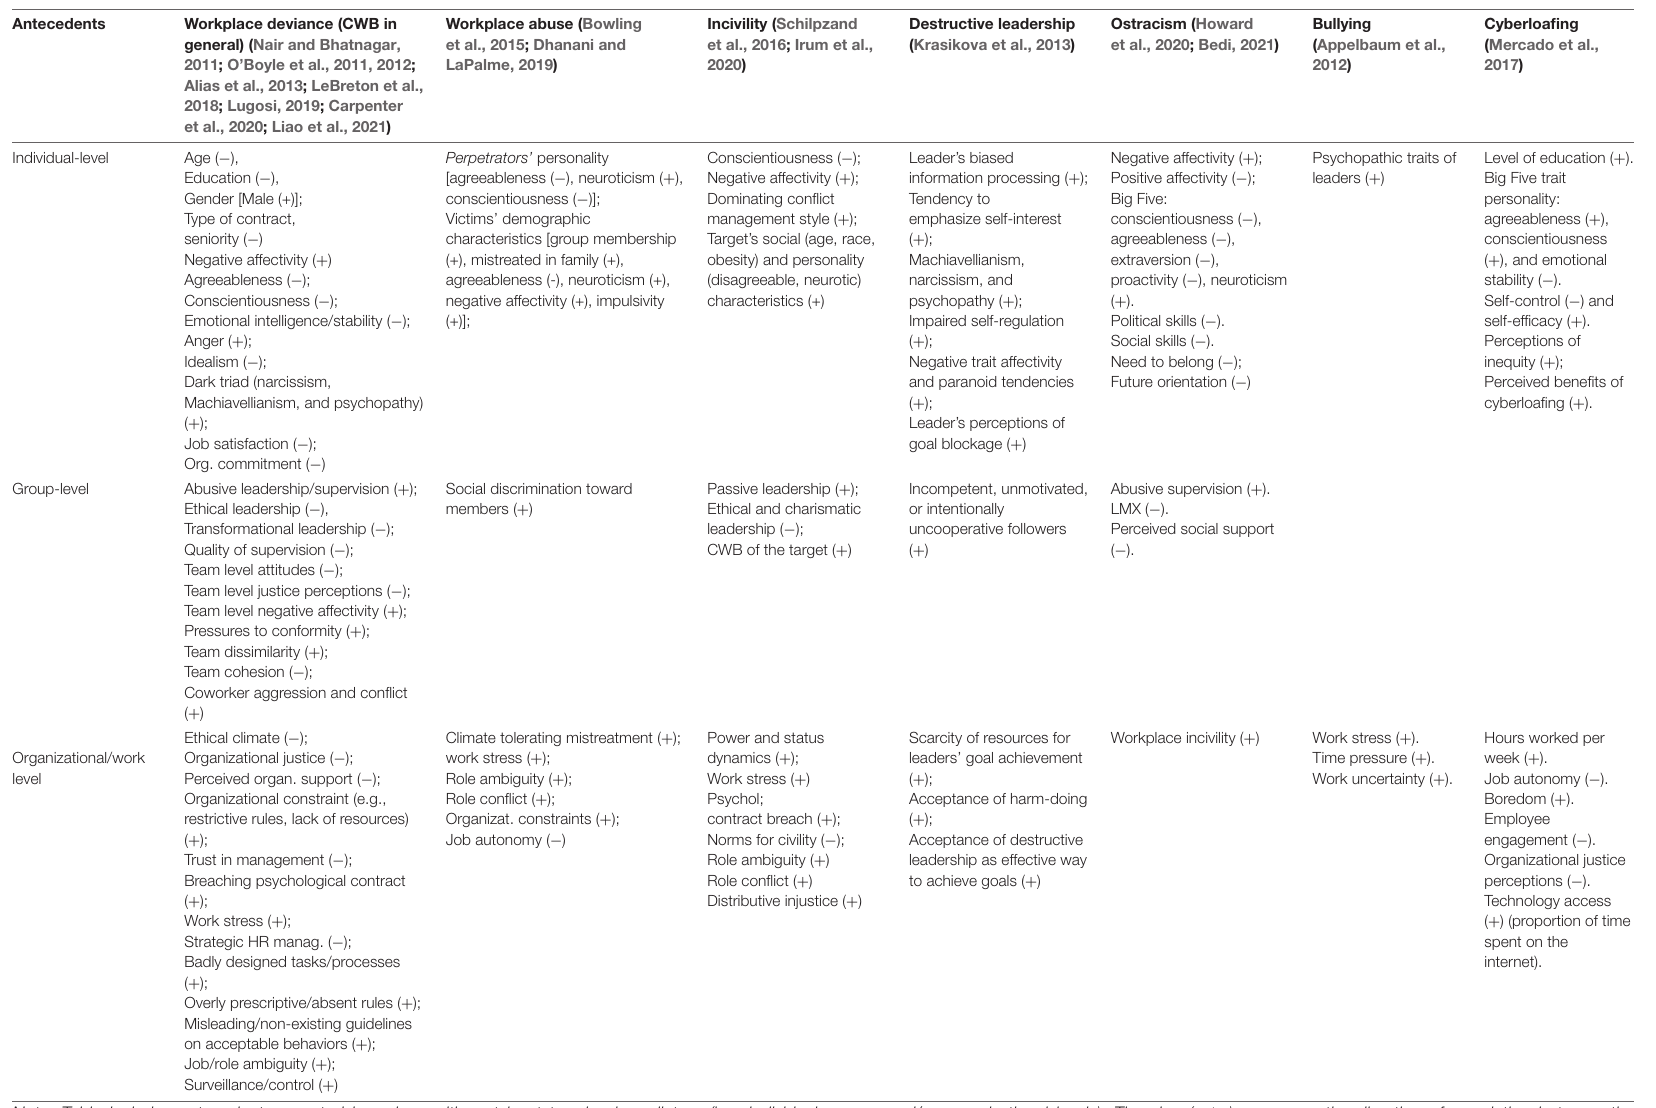
Note: Table includes antecedents reported in reviews citing at least two level predictors (i.e., individual, group, and/or organizational levels). The sign ( + / − ) expresses the direction of correlation between the antecedent and